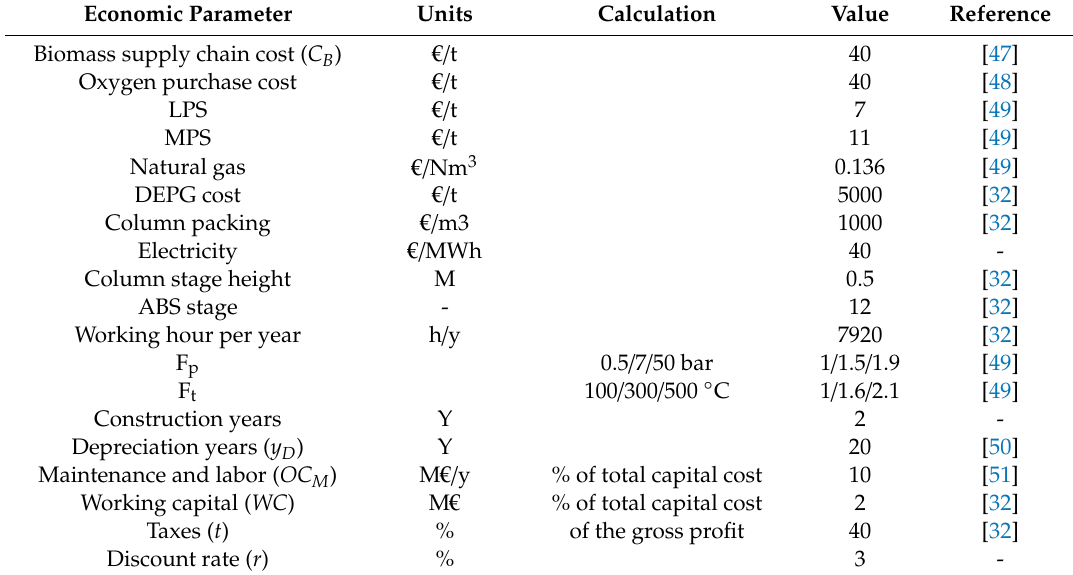
Table 4. Economic parameters used in the economic